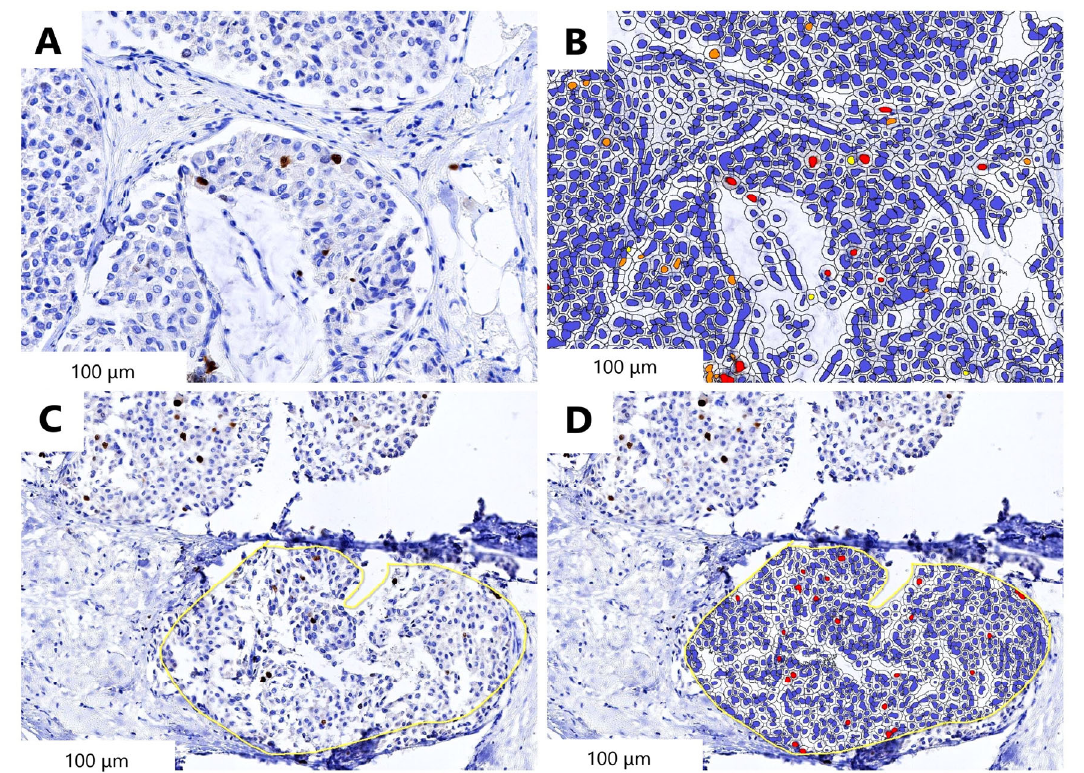
Figure 5. ( A ) Automatic detection of MIB-1 ′ s hot-spot area; ( B ) Detected tumor area (blue) and immunopositive cells (red); ( C ) Manually annotated tumor area (yellow outline); ( D ) Detected tumor area (blue cells) and immunopositive cells (red) inside the annotated area (yellow outline). The length bars shown in the WSIs (whole slide images) are 100 µm.